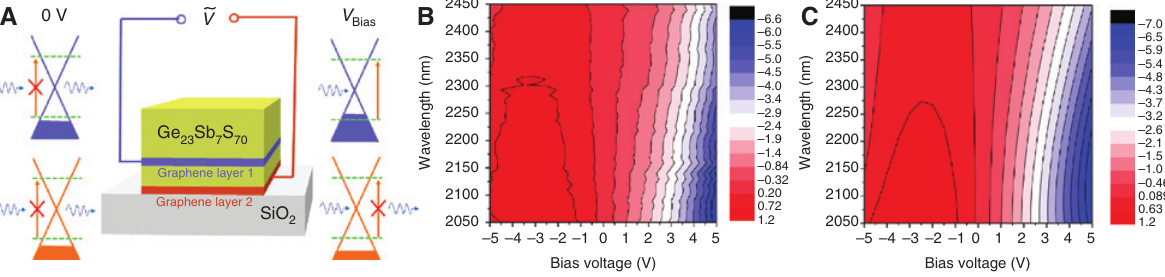
Figure 11: Graphene mid-IR waveguide modulator. (A) Center: schematic diagram of the graphene mid-IR waveguide modulator; left and right: band profiles of the two graphene layers, where the arrows represent energy of incident photons; (B) measured and (C) simulated color contour maps showing wavelength and bias depend- ent modulation depth of the device in dB/mm [142] (© 2017 Nature Publishing